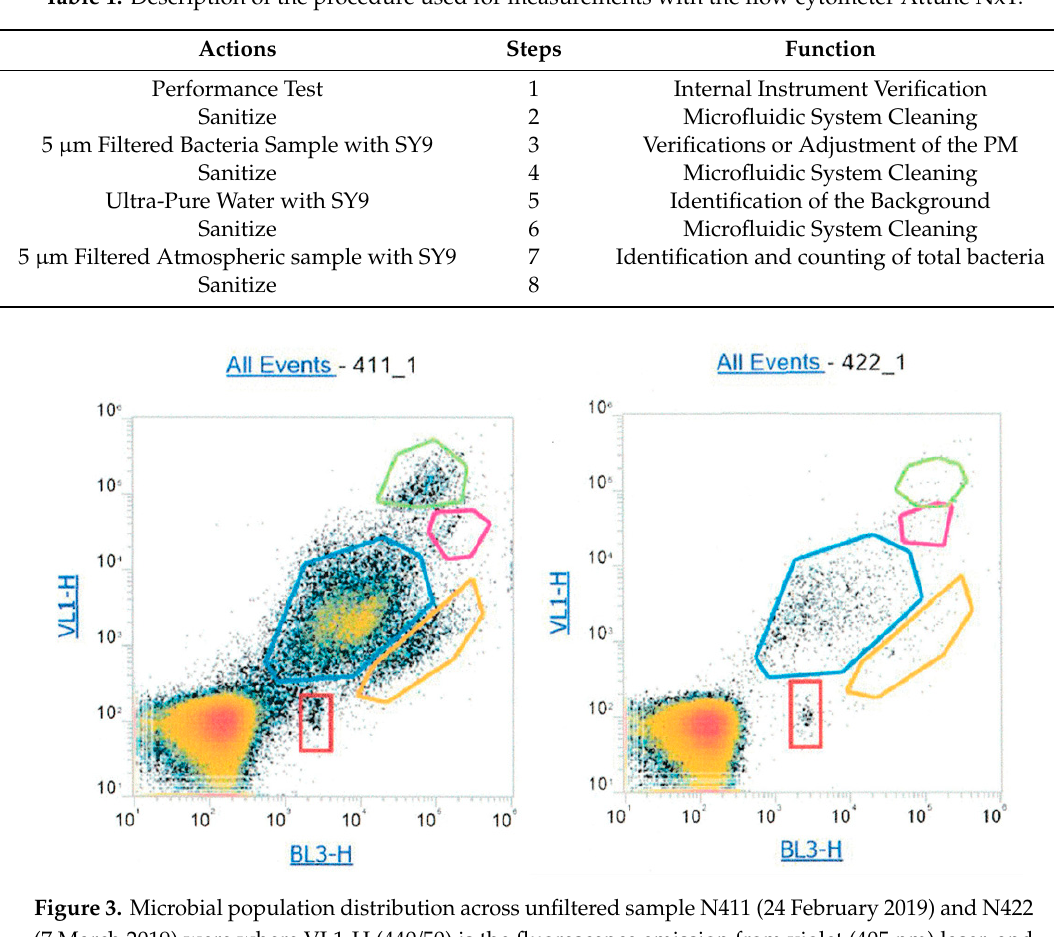
Table 1. Description of the procedure used for measurements with the flow cytometer Attune NxT.